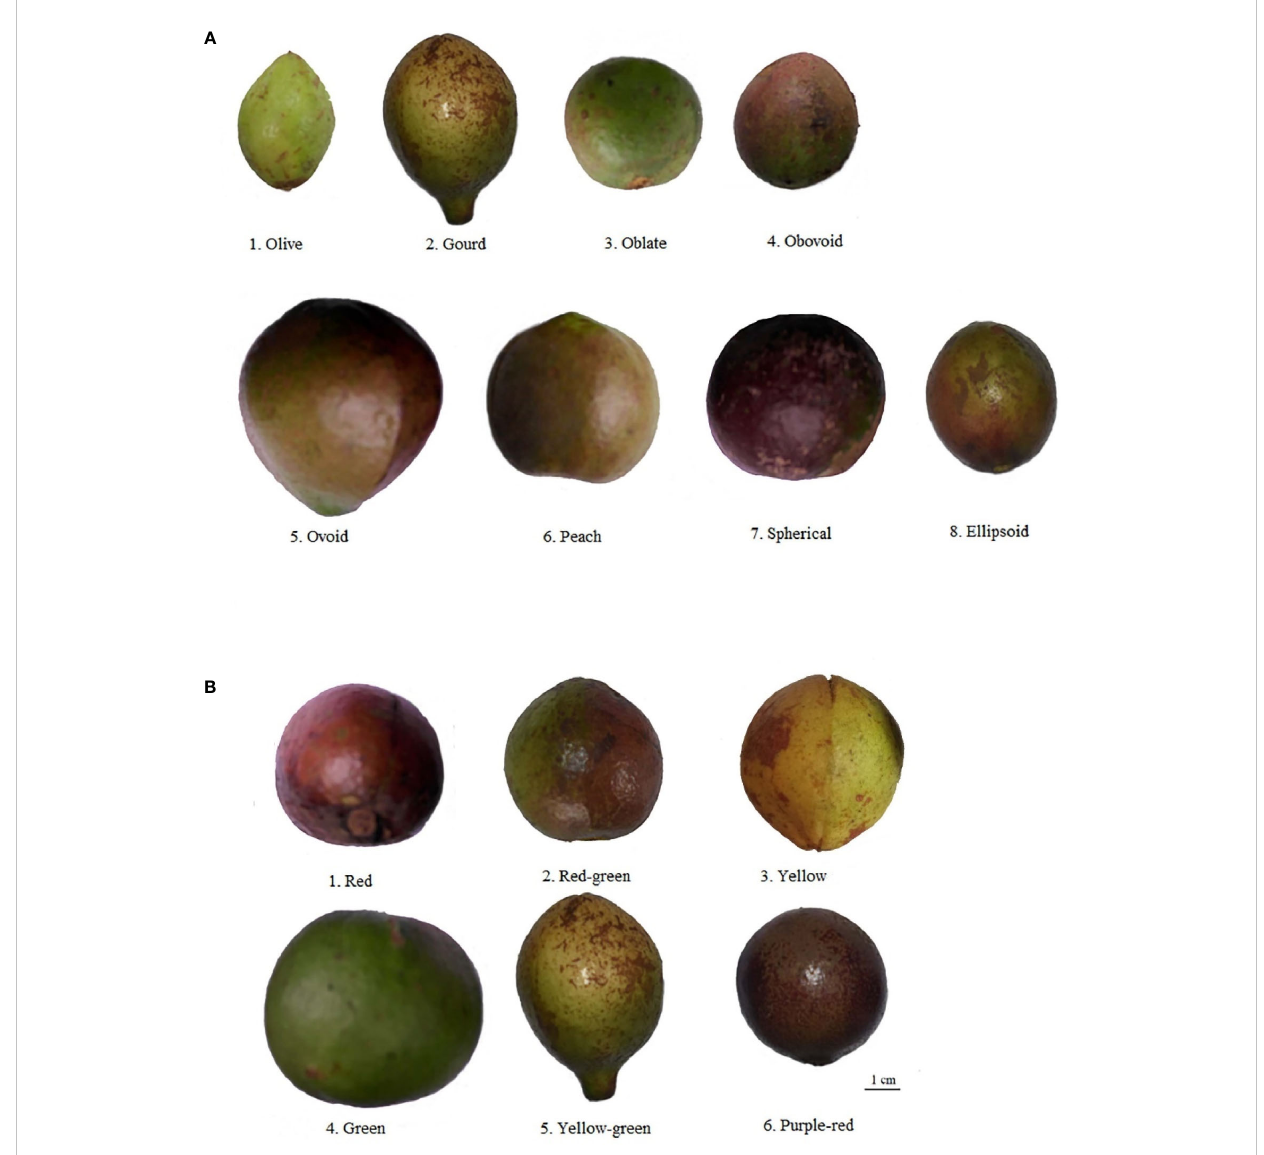
FIGURE 4 Rating of fruit morphologic characters for wild C. oleifera germplasm resources: (A) fruit shape and (B) peel